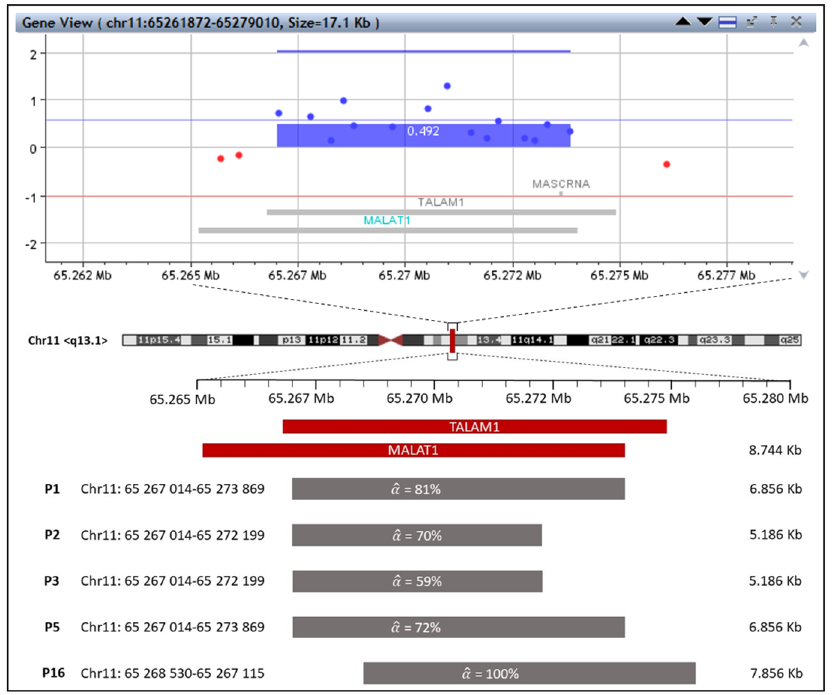
Figure 1. The representative example of gain in region encoding MALAT1 , TALAM1 , and MAS- CRNA is pictured as a blue rectangle in the region at chr11, q13.1, in adenoma of P1 at the top of the image. Thin horizontal red and blue lines represent values corresponding to the non-mosaic state of deletions ( − 1) or duplications (0.58). A comparison of this gained region between patients from the first group (P1, P2, P3, P5, and P16) is shown at the bottom of the image. Mosaicism of each patient is expressed by the symbol ˆ α